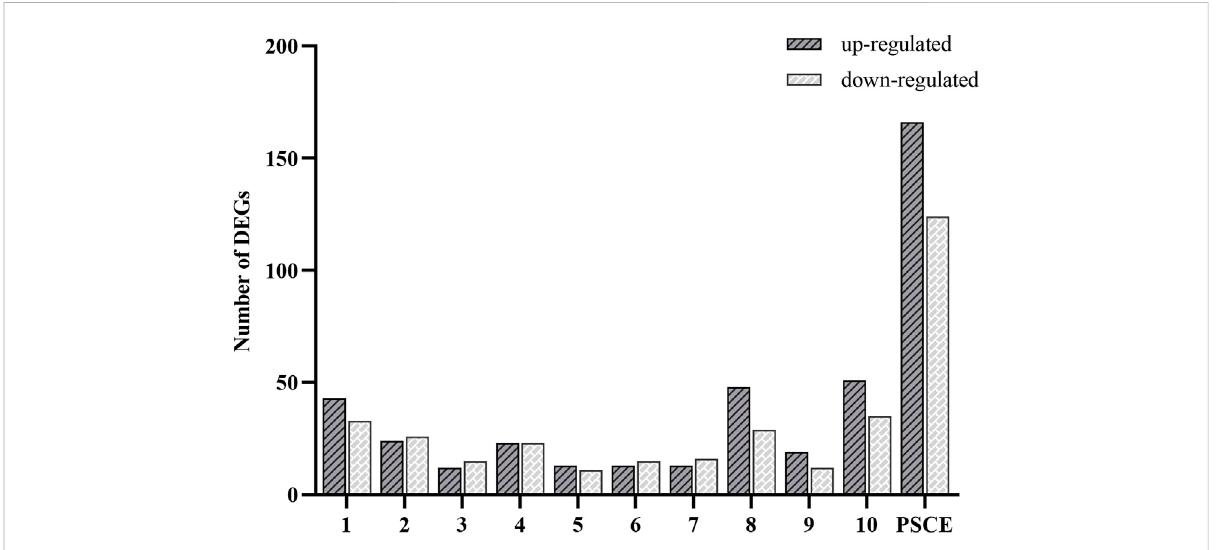
FIGURE 2 AnalysisofDEGsbetween drug-treatedanduntreatedgroups(n=4pergroup).Abscissa:differentdrugs, including10stilbenes(1.suffruticosol A; 2. suffruticosol B; 3. suffruticosol C; 4. trans -resveratrol; 5. cis- ε - viniferin; 6. trans- ε -viniferin; 7. cis -suffruticosol D; 8. cis -gnetin H; 9. trans - suffruticosol D; 10. trans -gnetin H) and PSCE (the seed coat extracts of Moutan), ordinate: number of the up-regulated and down-regulated DEGs. The length of the column indicated the number of DEGs in this